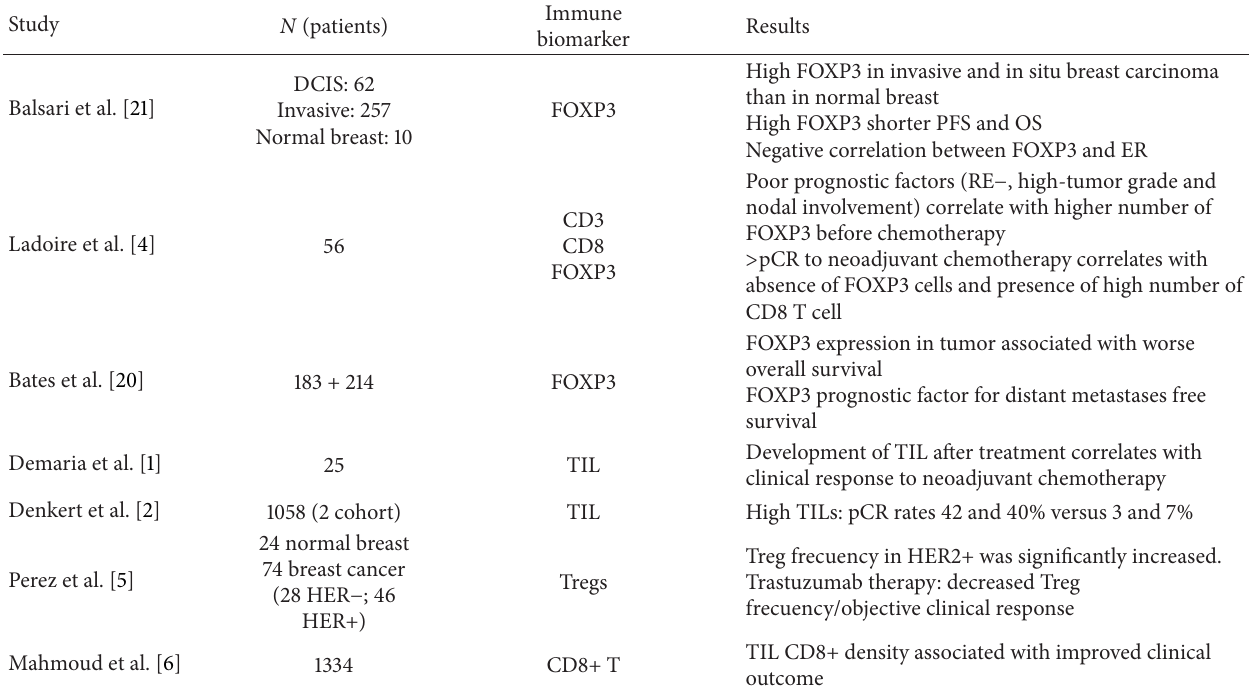
Table 1: Studies correlating immunobiomarkers with clinical